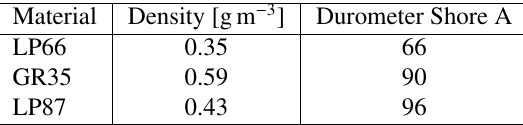
Table 1. Important technical parameters of the polishing pad materials used. The higher the durometer Shore A value, the more resistant the material is to penetration and the harder it is.